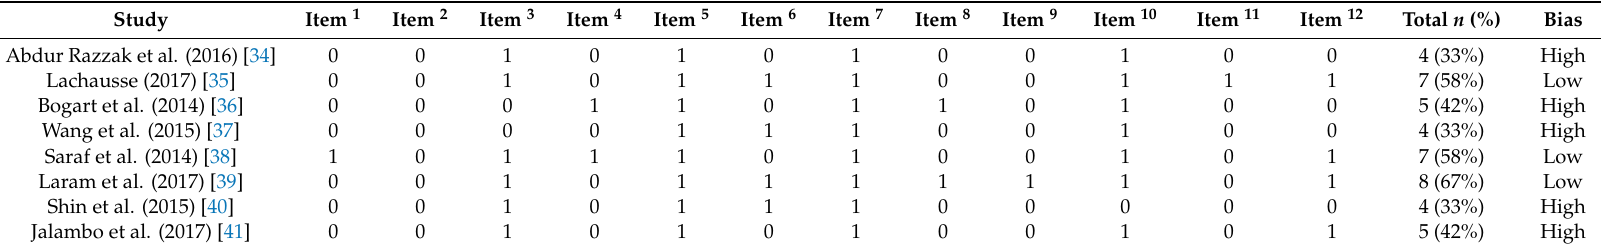
Table 3. Risk of bias ratings for each study